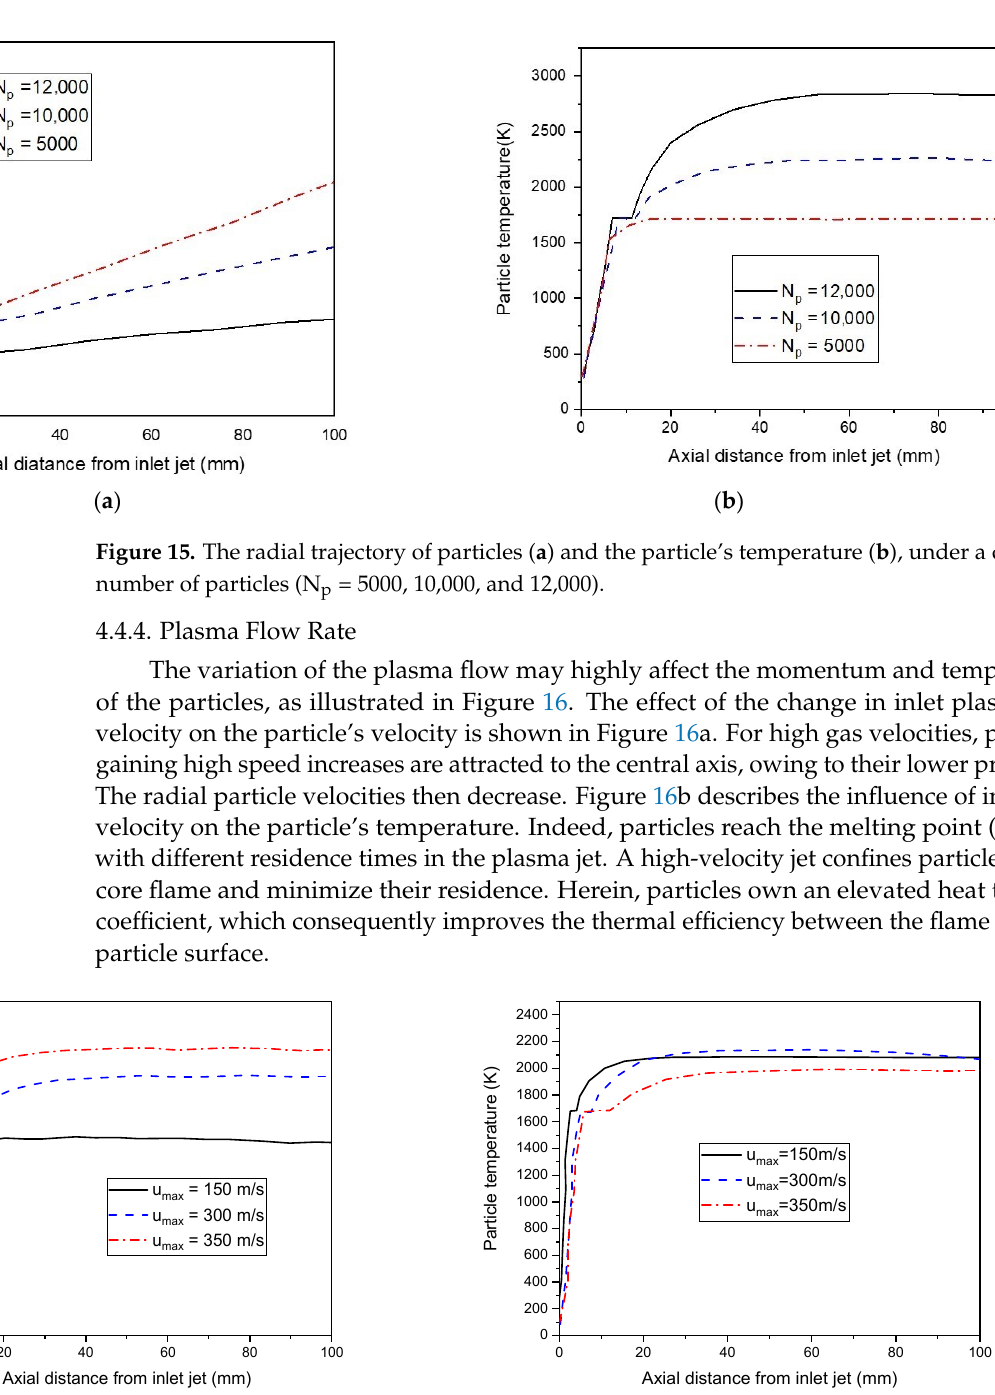
Figure 16. The axial particle velocity ( a ), and the particle temperature ( b ) distributions, under different initial velocities plasma flow rate (u max = 150, 300, and 350 m/s). Here, various initial plasma temperatures are predicted by the model, and their effects are shown in Figure 17. The particle temperature increases at high temperature of plasma gas, even when they have a short residence time with high velocities. Indeed, a plasma temperature of 8000 K cannot melt the particles of silicon. Raising the temperature of plasma flow is beneficial for particle temperature because it increases the heat transfer coefficient, in addition to increasing the relative particle